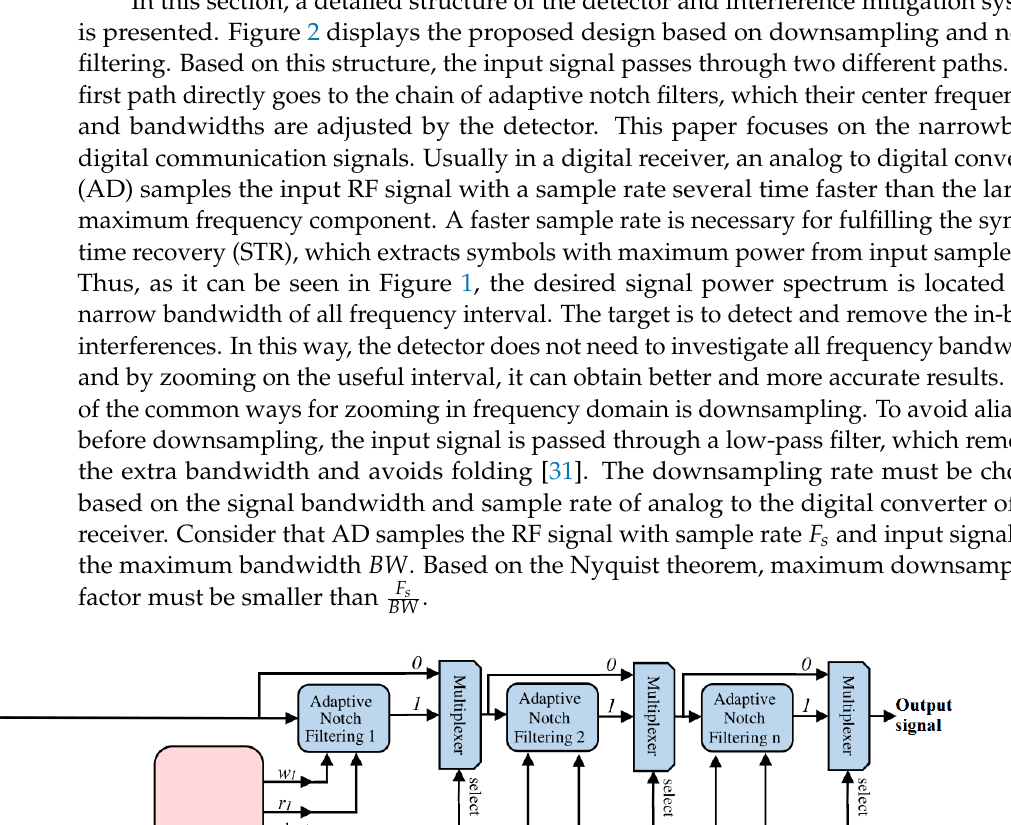
( b ) Figure 3. ( a ) Original power spectrum of a modulated signal ( b ) power spectrum of the signal after downsampling.